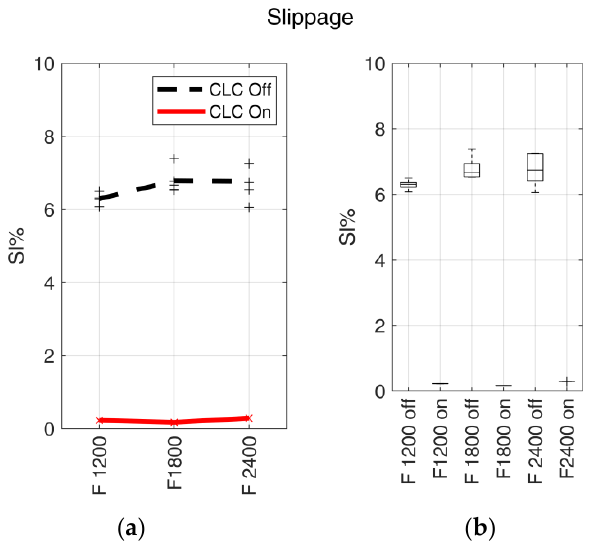
Figure 5. Slippage. ( a ) Slippage trends for the fabrication feed rates (expressed in mm/min). Markers indicate the average slippage value for single tests ( Sl% (F,CLC) ), and bold lines indicate the mean values. The continuous red line indicates the samples realised with enabled CLC, and the black dashed line indicates the samples realised with disabled CLC. ( b ) Box plots of Sl% vs. filament feed rate, F, with enabled (on) and disabled (off) CLC.